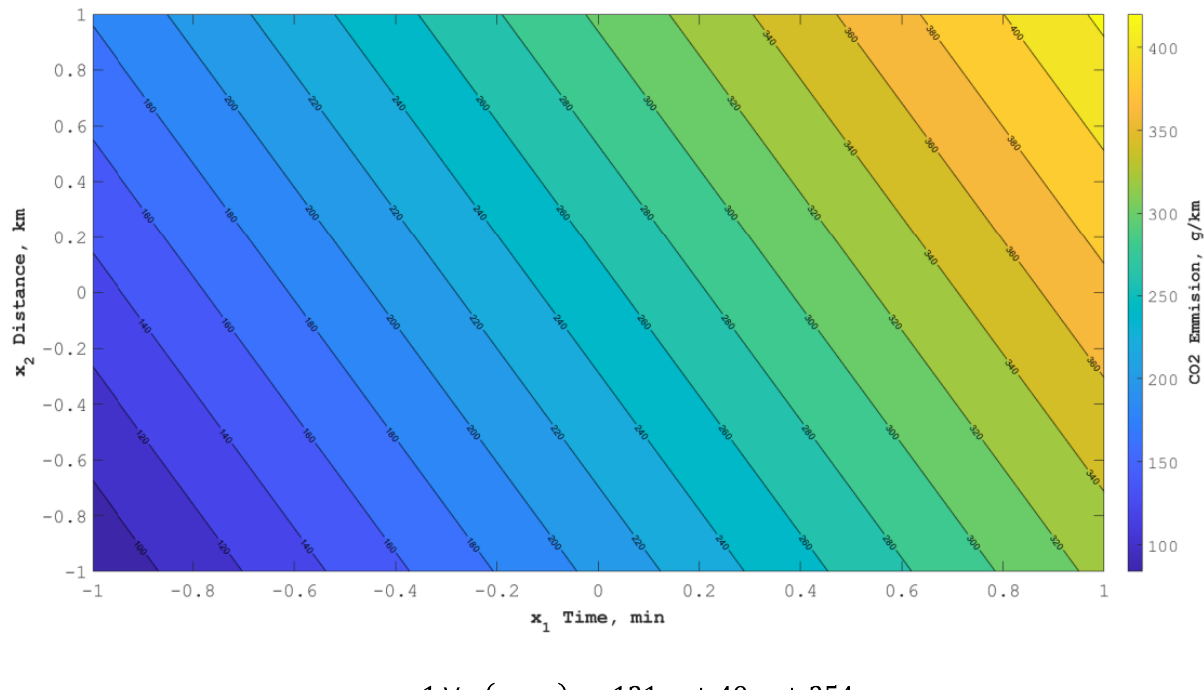
Figure 17. Change in CO 2 emissions depending on the variability of factors x 1 and x 2 for a vehicle (EV) moving at a temperature of 15 °C (x 3 = −1 ).